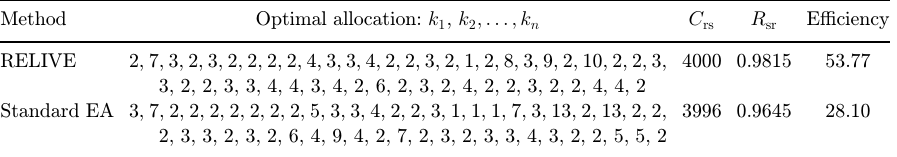
Table 6. The best solutions found by the considered methods: Experiment II, Problem 2. Method Optimal allocation: k 1 , k 2 ; ... ; k